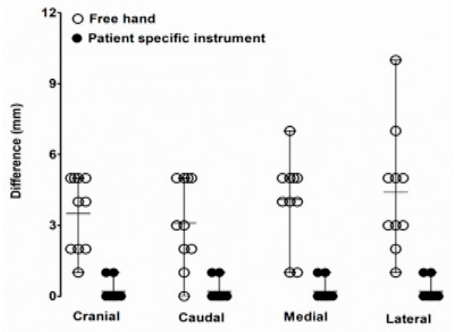
Figure 12. Distance (mm) from the target plane to the cut plane: freehand versus patient ‐ specific instrumentation (PSI). The measurement point was set on the cranial, caudal, medial, and lateral surfaces of the rapid prototyping phantom bone model. In the PSI group, accuracy test results showed less than 1 mm distance from the target plane. On the other hand, the freehand method group results showed up to 11 mm of error from the target plane.